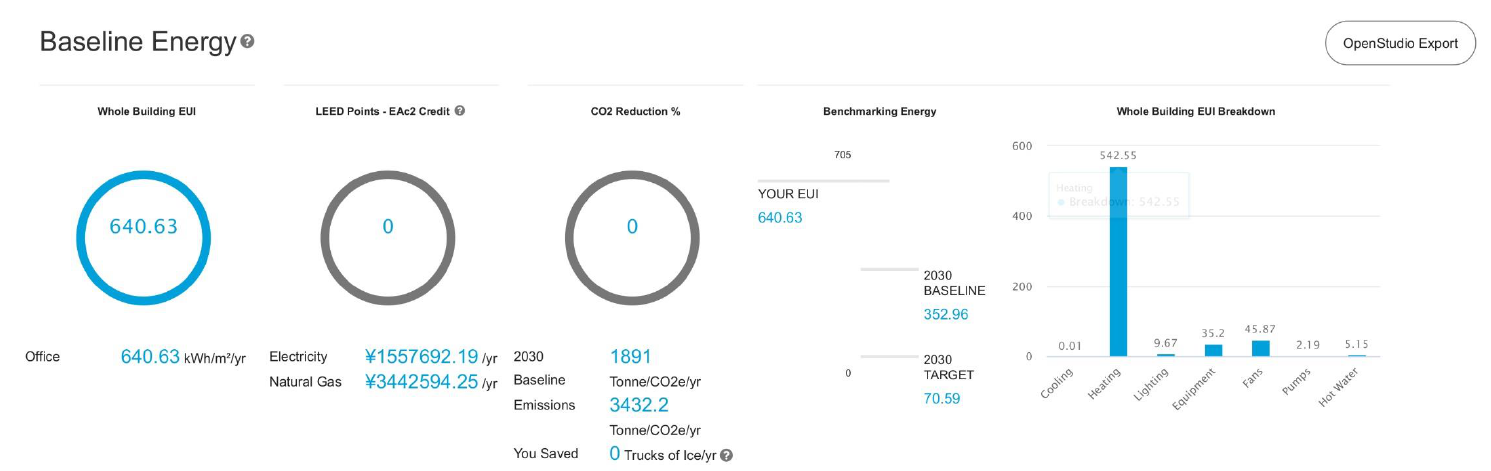
Clean Technol. 2022 , 4 , FOR PEER REVIEW Figure A43. Zone 7-H Delingh á , Qinghai (pre-COVID-19 scenario). Figure A43. Zone 7-H Delinghá, Qinghai (pre-COVID-19 scenario).